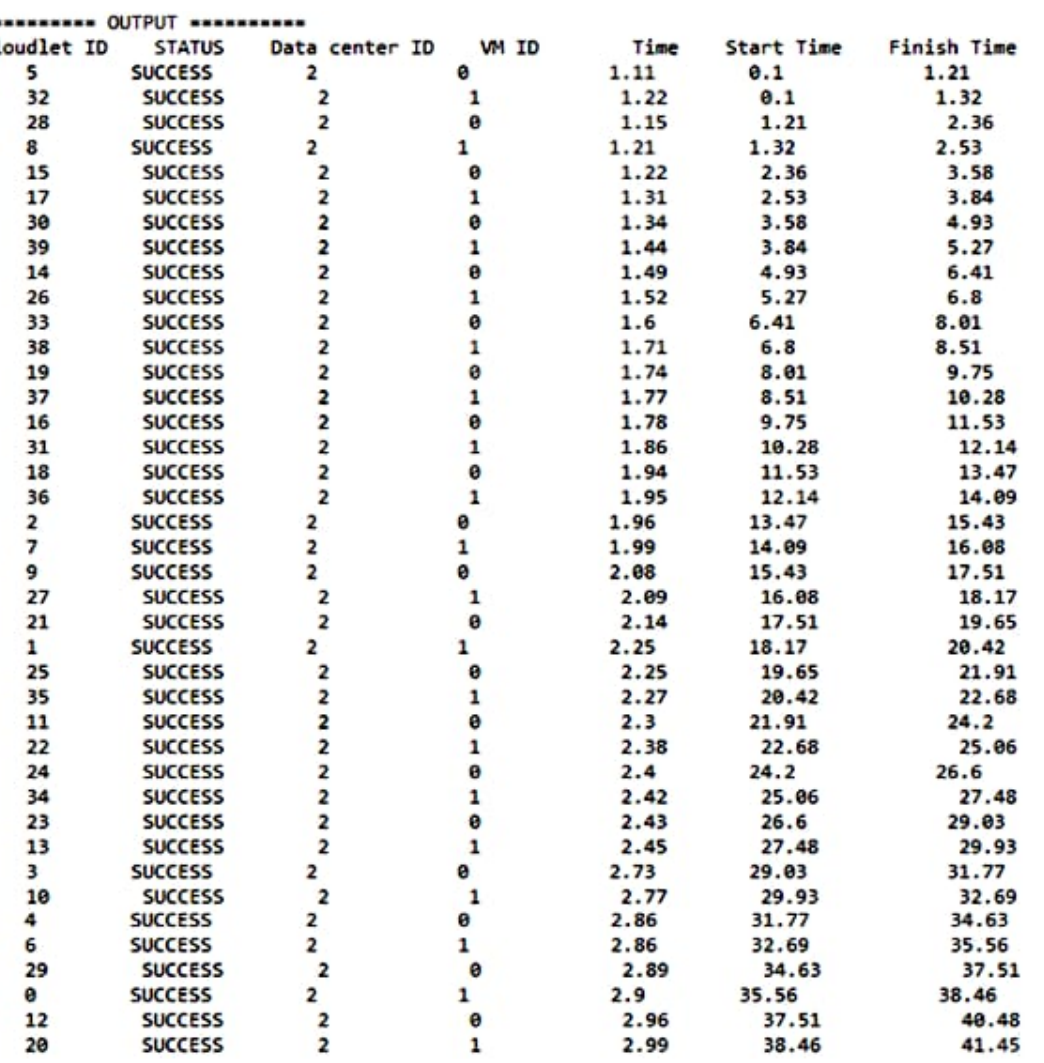
Table 6. Total computation time (ms) and waiting time (ms) in Scenario-1 and Scenario-2. Experiment